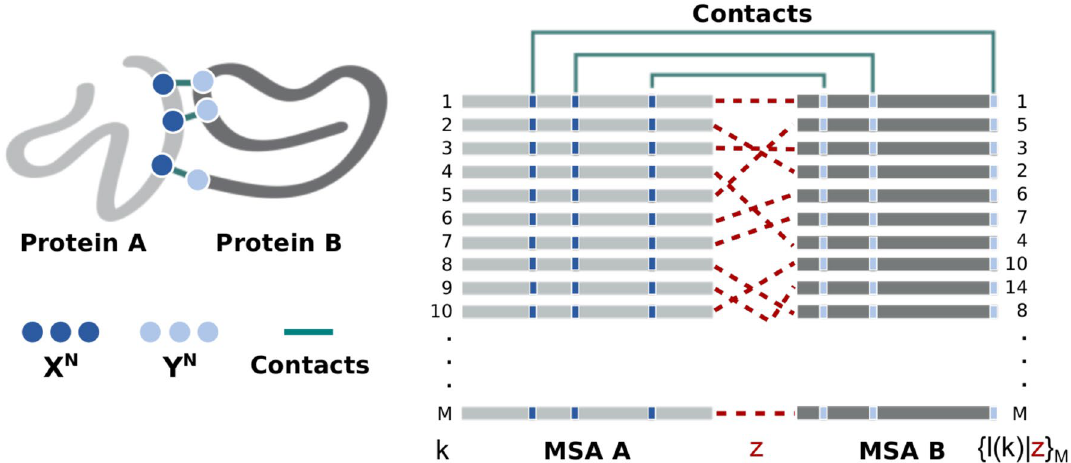
Figure 7. Structural contacts mapped into M -long multi-sequence alignment of protein interologs A and B . A set of pairwise protein–protein interactions is defined by associating each sequence l in MSA B to a sequence k in MSA A in one unique arrangement, { l ( k ) | z } , determined by the coevolution process z to which these protein families were subjected. This figure was created with Inkscape (https:// inksc ape.